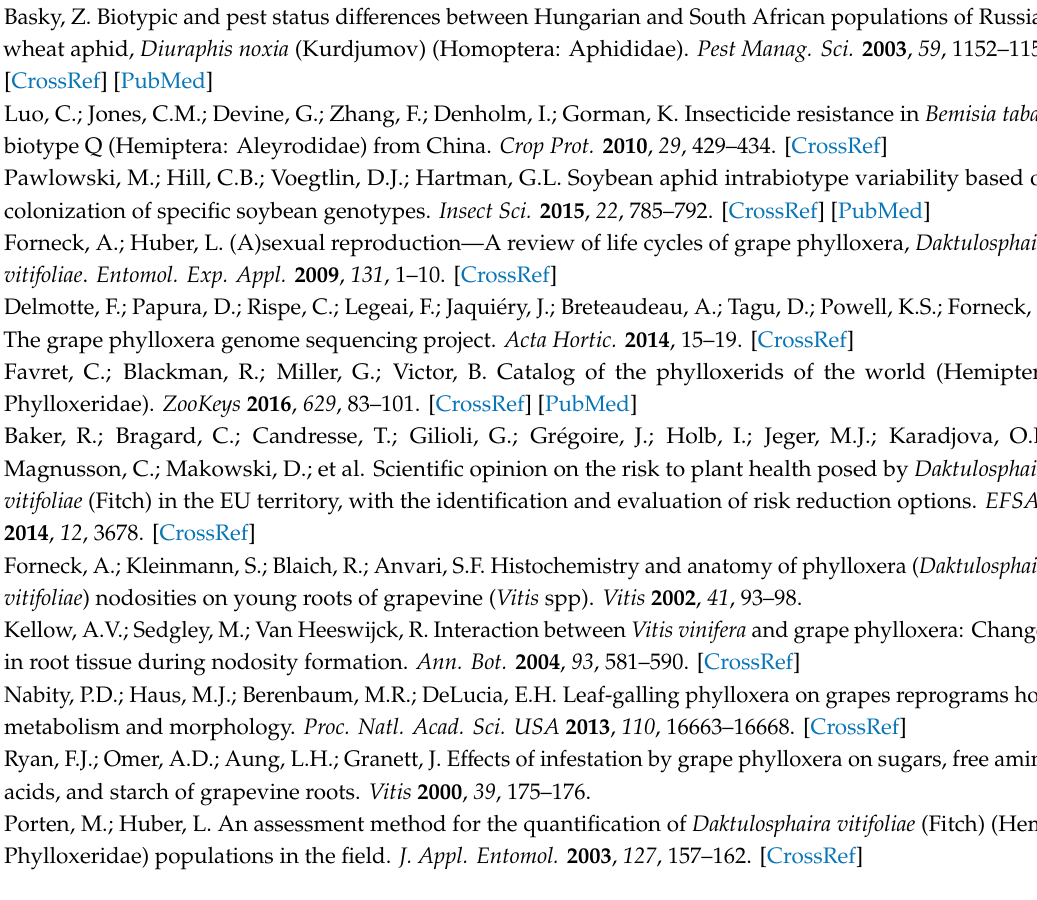
Figure S1: Schematic representation of the analyses described. Table S1: Transcriptome data metrics. File S1: Summary of di ff erentially expressed genes (a) during development in the biotype A and C; commonly higher expressed genes (b) in L1 and (c) in L2-3; (d) results of the enriched GO analysis in L1 and L2-3. File S2: List